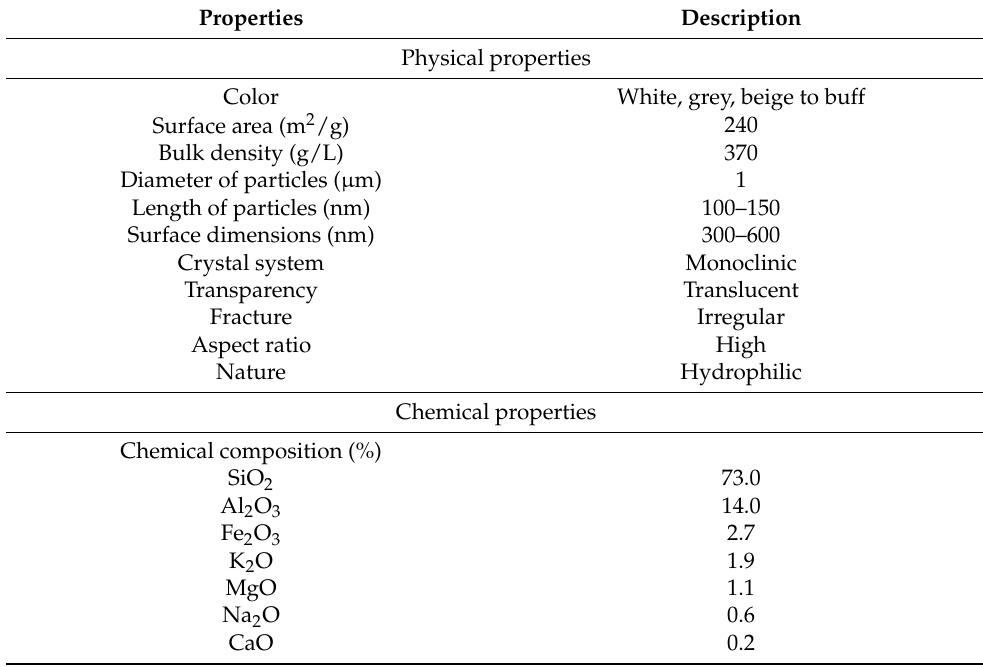
Table 1. Physical and chemical characteristics of